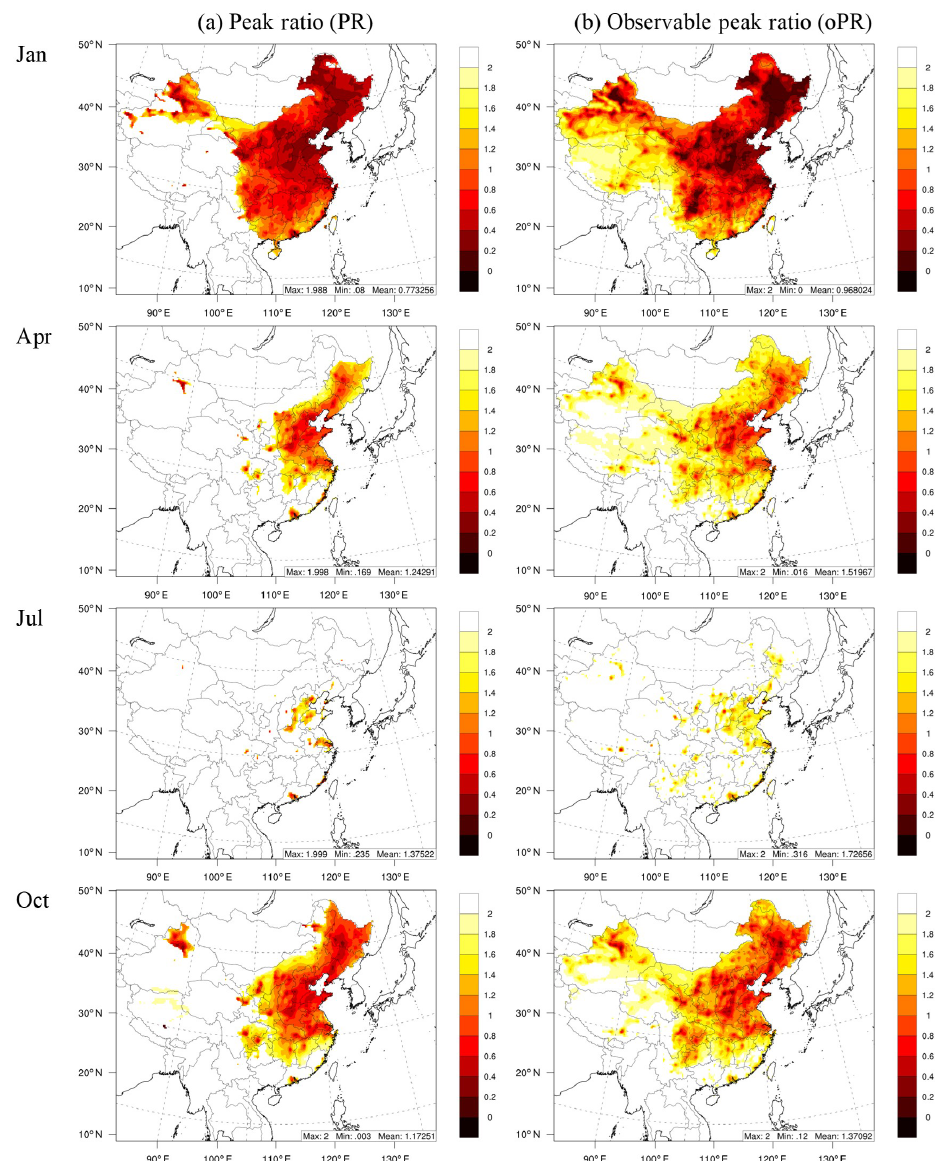
Figure 7. Comparison of the PR derived from the RSM with that calculated from concentrations for O 3 chemistry. The oPR was estimated based on H 2 O 2 × HCHO / NO 2